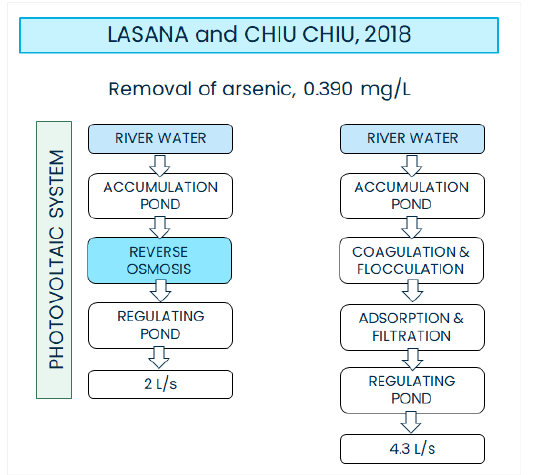
Figure 2. Scheme of the treatment trains for the APR WTP of Lasana ( left ) and Chiu-Chiu ( right ).